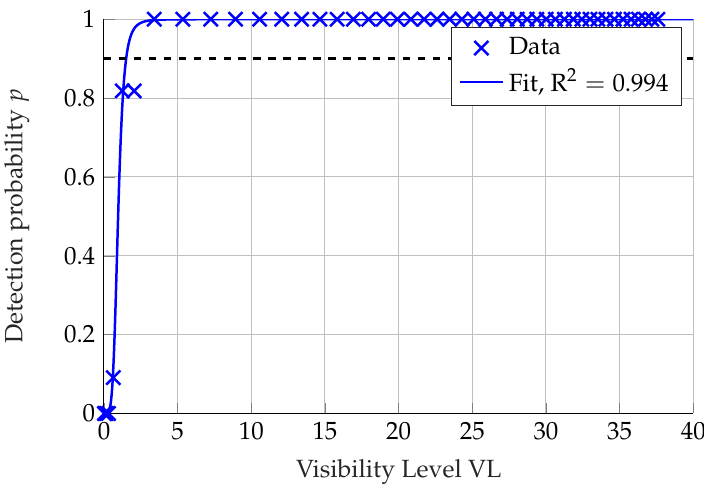
Figure 10. Relationship between the detection probability p and the Visibility Level VL of the gray card at object position 1 in the light tunnel; to achieve a detection probability p of 90%, a Visibility Level of 1.505 is required.